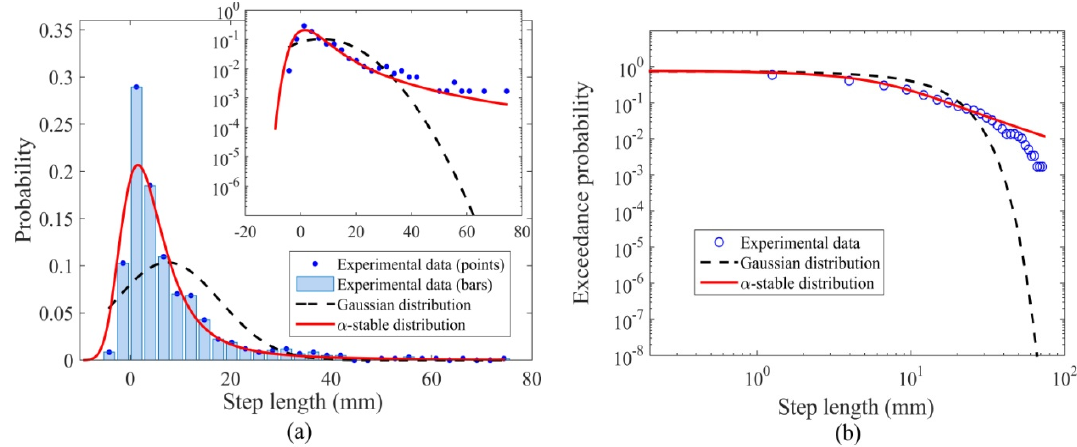
Figure 6. ( a ) Discrete probability distribution of the particle step length ( ∆ t = 0.1 s) with theoretical lines that fit the data; the inset shows the same data on a semilog plot. ( b ) Exceedance probability of the particle step length.